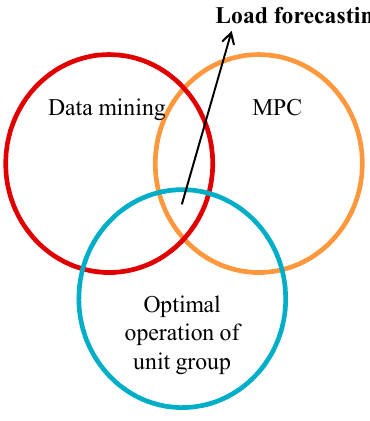
Figure 3. Load forecasting in cross disciplines.